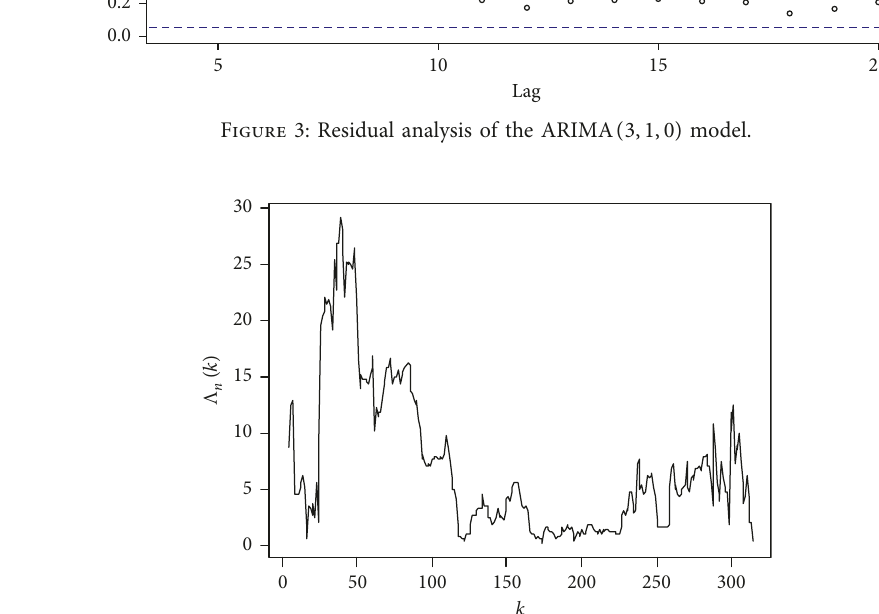
Figure 4: Values of statistic